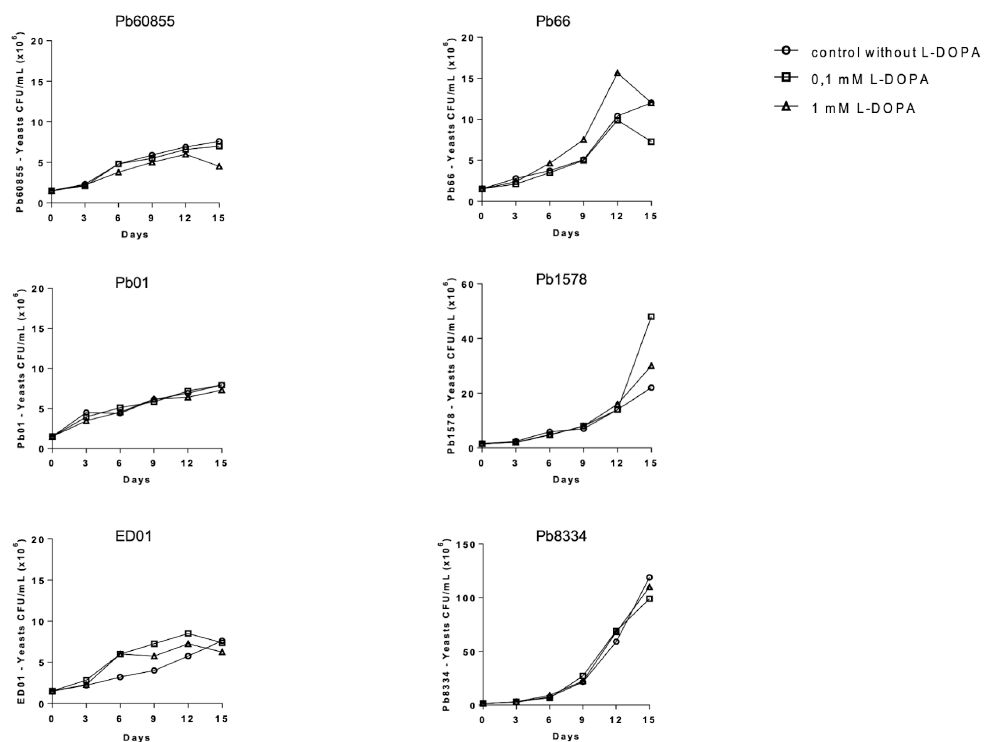
Figure 1. Growth of Paraccocidioides without or with L-DOPA (0.1 and 1 mM). The growth of the di ff erent isolates of Paracoccidioides was measured by CFU determinations at 3, 6, 9, 12, and 15 days of cultivation at 37 ◦ C. P. restrepiensis (Pb60855), P. lutzii (Pb66, Pb01, Pb1578, ED01, and